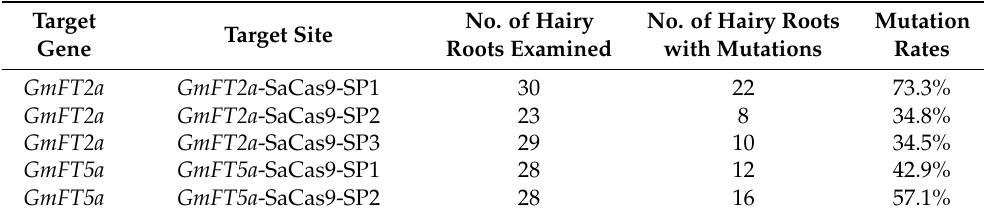
Figure 1. Site-specific mutations induced by the CRISPR/SaCas9 in target gene GmFT2a . ( A ) Gene structures of GmFT2a with three target sites of CRISPR/SaCas9. Blue stripe, exon; black solid line, intron; gray stripe, UTR (untranslated region). The red letters are PAM (protospacer adjacent motif) sequences. ( B – D ) Sequences of WT (wild type) and representative mutation types induced at target sites GmFT2a -SaCas9-SP1, GmFT2a -SaCas9-SP2 and GmFT2a -SaCas9-SP3 are presented, respectively. Underline, insertions. Dashes, deletions. The red arrowheads indicate the location of mutations. Table 1. Summary of CRISPR/SaCas9 genome editing assays in the present